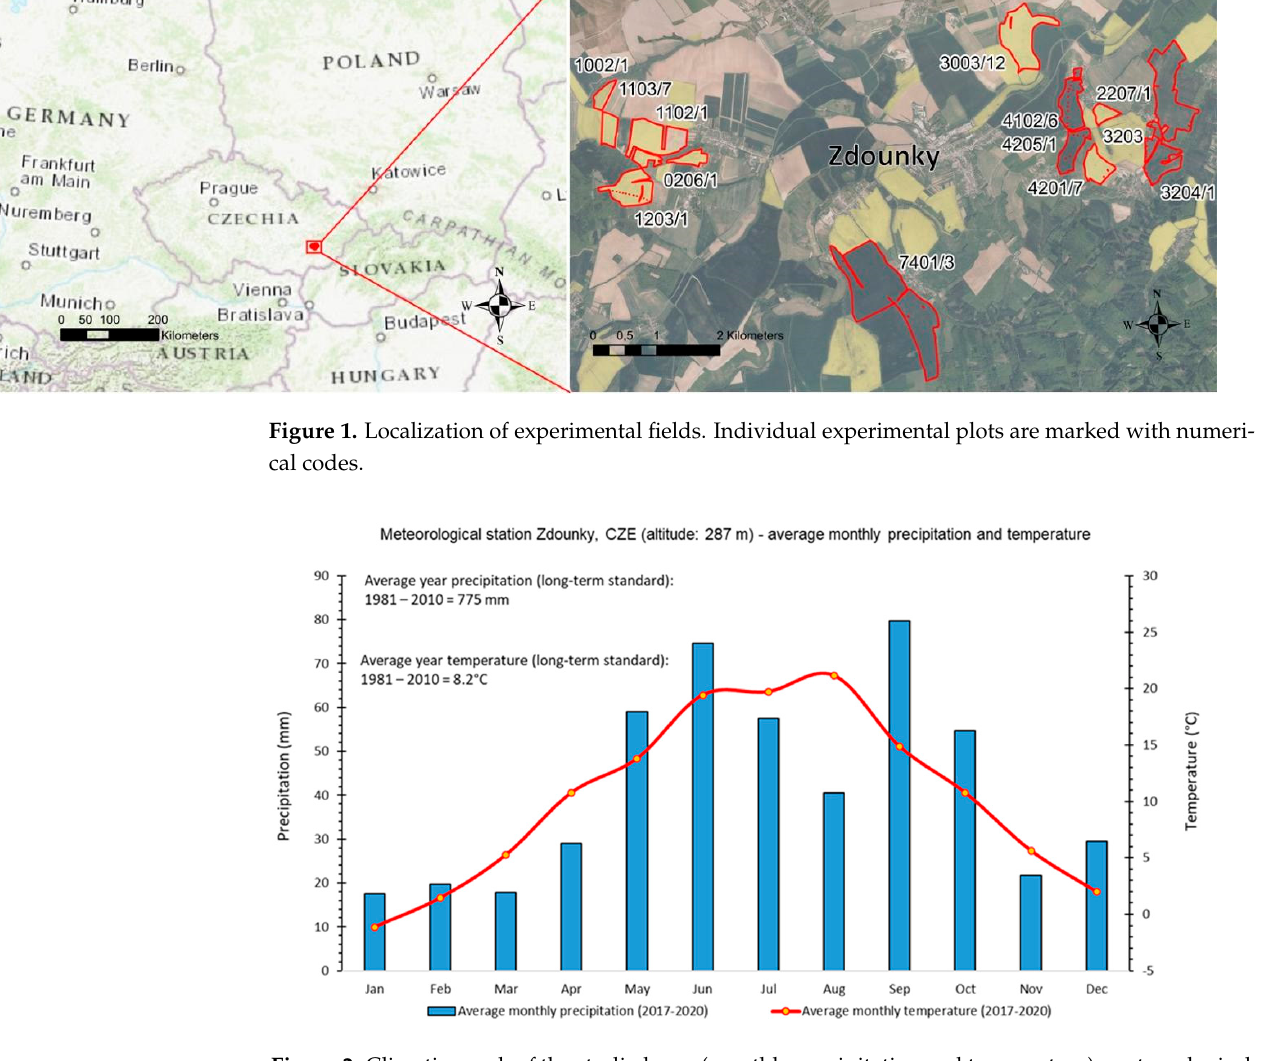
damp (T3, MT2). The long-term average annual temperature was 8.2 °C in 1981–2010. The long-term average annual precipitation amount (1981–2010) was 775 mm (Figure 2). The fields are located at an altitude of 205–390 m a.s.l. Soil types are medium deep Chernozem, Haplic Luvisol, Cambisol and Fluvisol. The humus content is moderately high, equal to 2–3%. The soil pH ranges between 6.6 and 7.2. The fields are flat to moderately sloping. Figure 1. Localization of experimental fields. Individual experimental plots are marked with numerical codes.